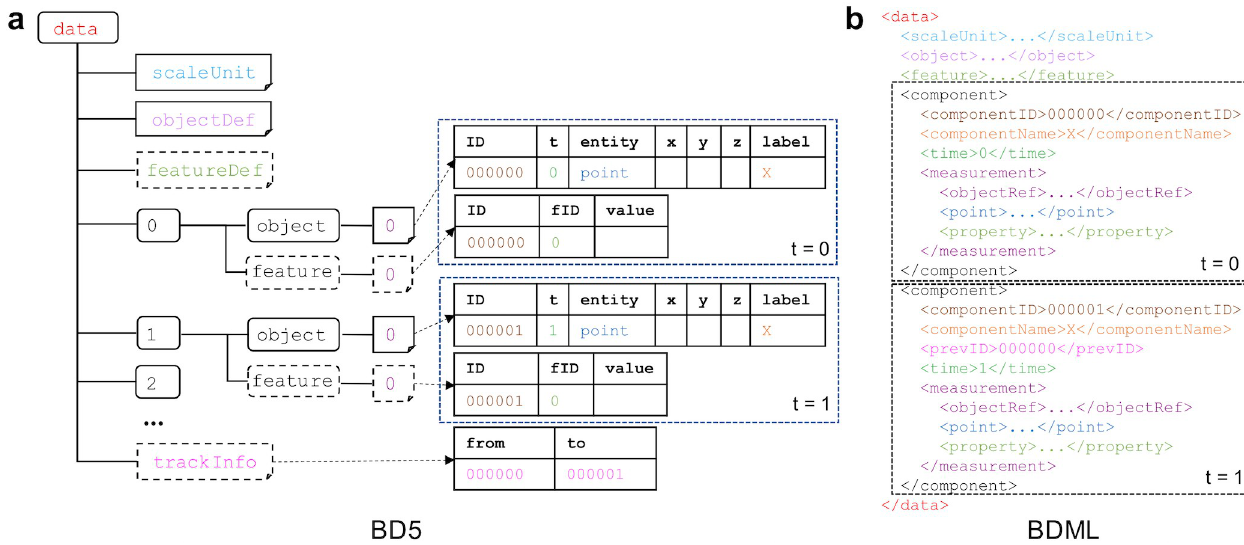
Fig 6. Comparison of the structures between the BD5 (a) and BDML formats (b). Corresponding elements in the two formats have the same colors. Whereas BDML describes all the information in a linear structure, BD5 has an additional hierarchical time-ordered sequence (numbered groups) to separate spatial information about biological objects in